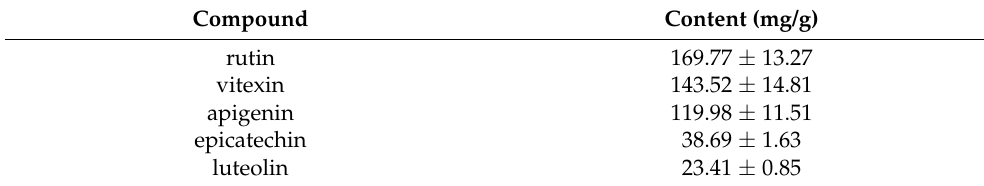
Table 1. The contents of flavonoids in the FCF extract.